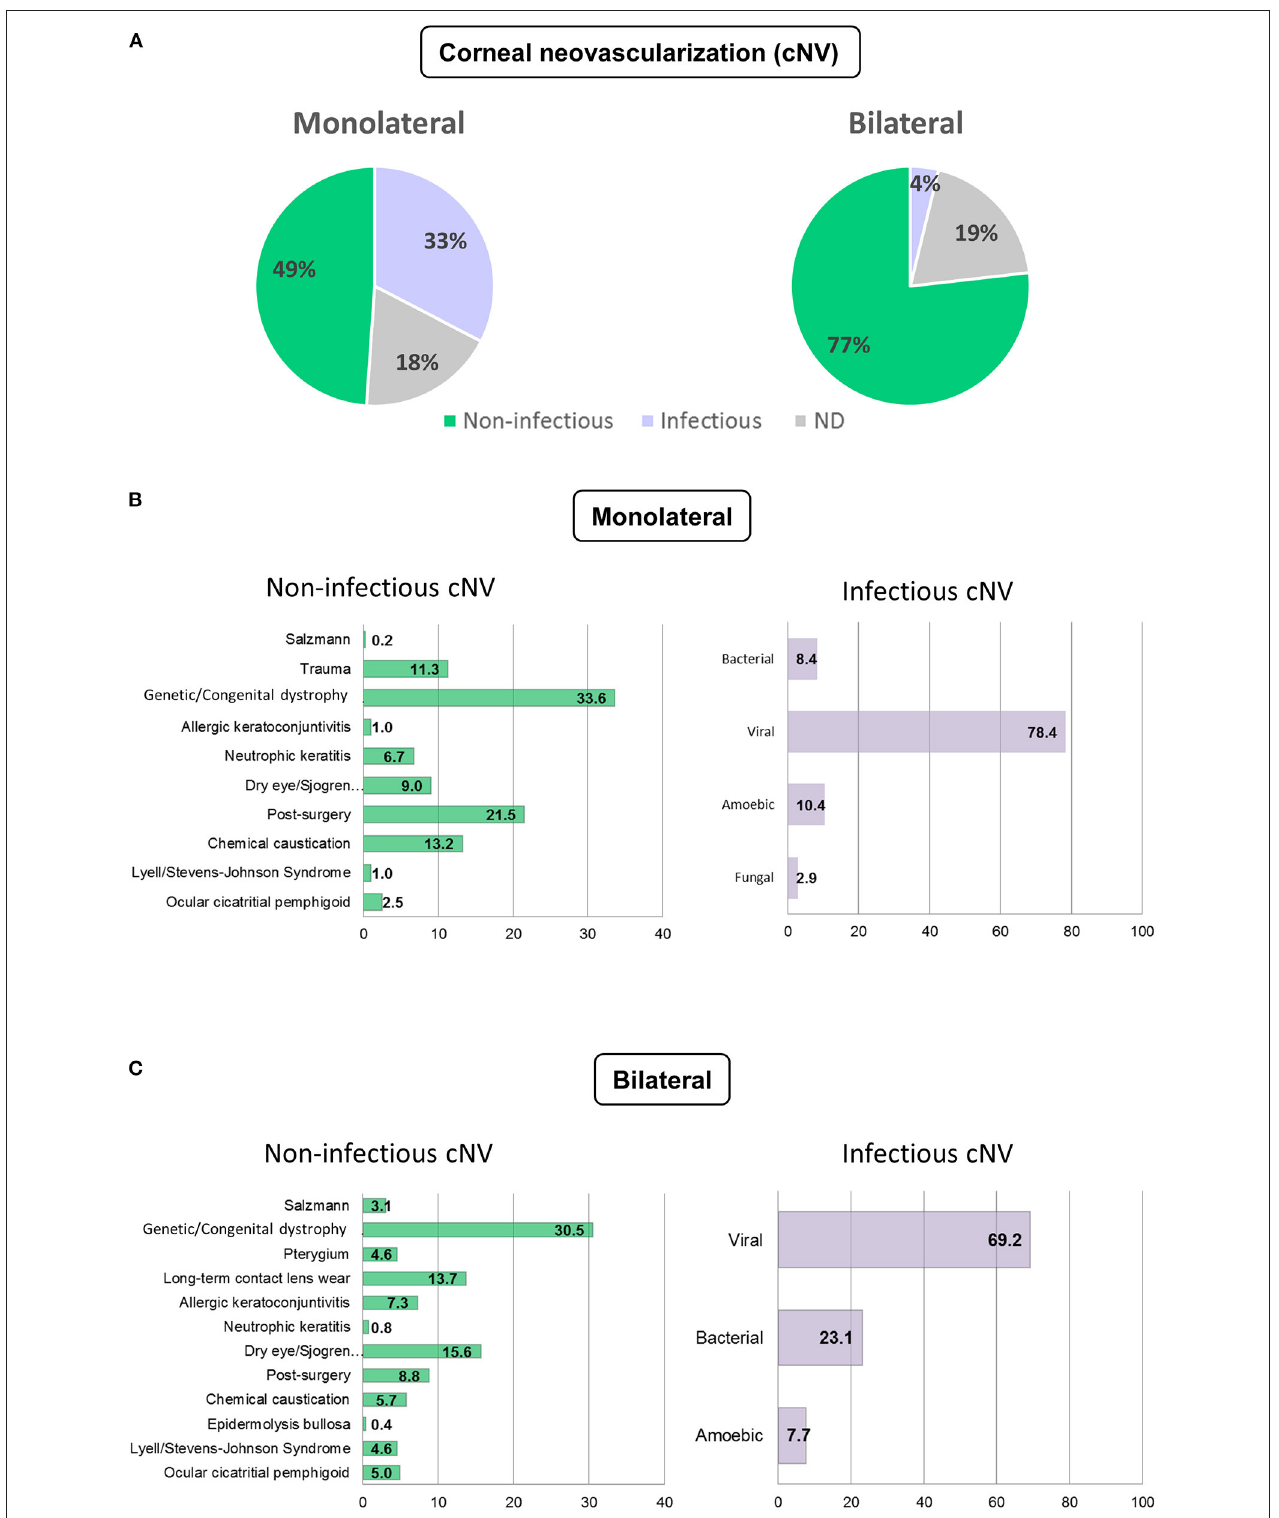
FIGURE 1 | Etiology of corneal neovascularization (cNV). Etiology of monolateral and bilateral cNV that are classified as infectious, non-infectious, and non-determined (ND) (A) Distribution of the patients with infectious and non-infectious keratitis in monolateral (B) and bilateral (C) cNV.